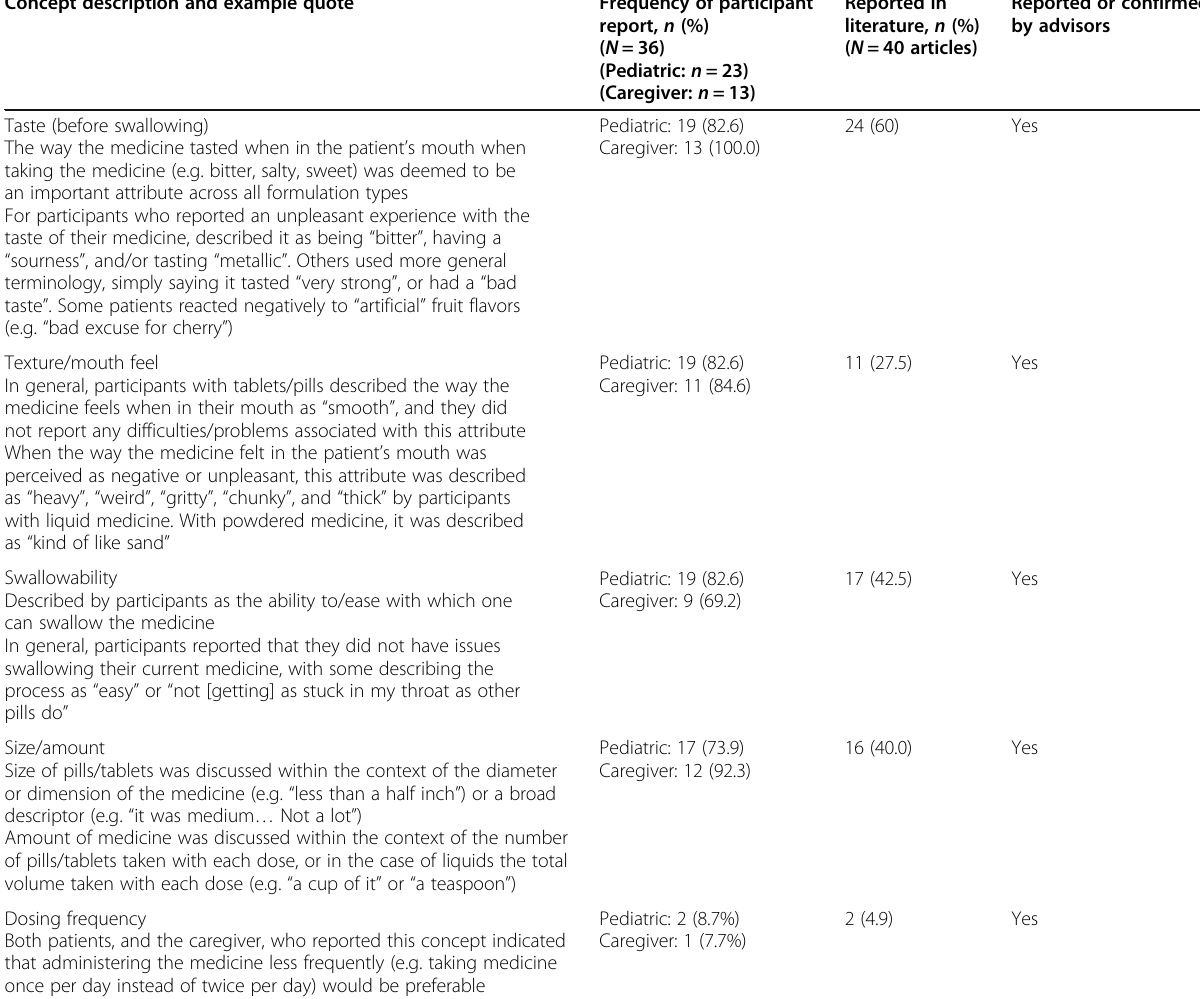
Table 5 Example of the concept tracking matrix for attributes included in the Pediatric Oral Medicines Acceptability Questionnaires Concept description and example